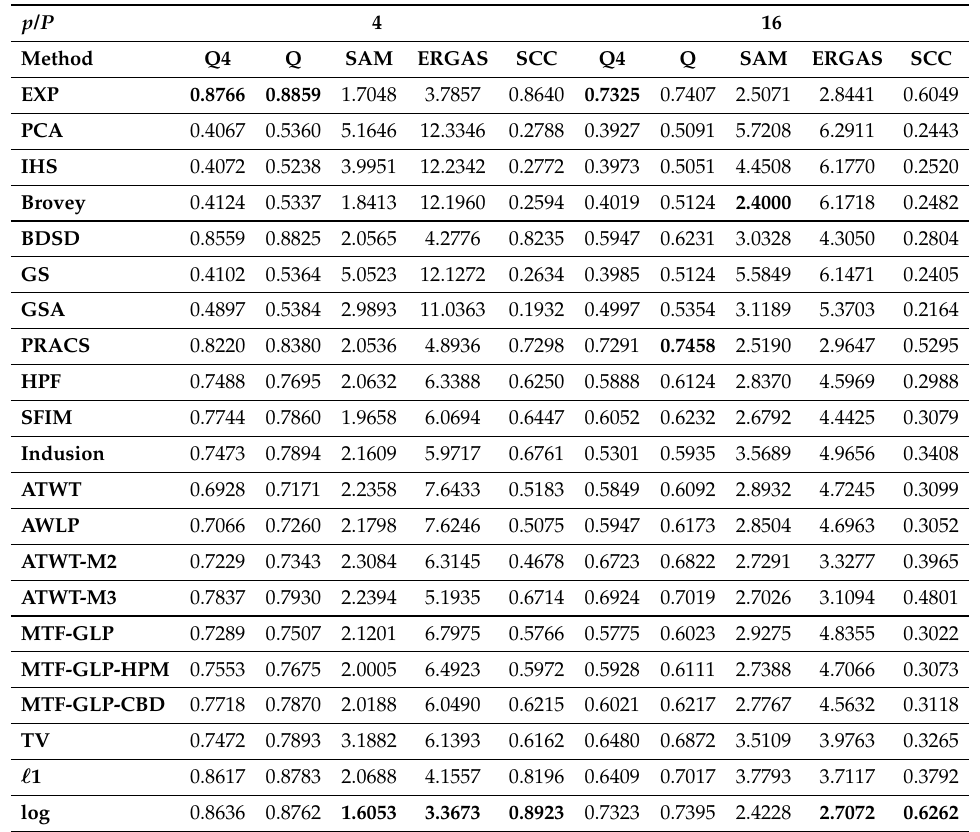
Table 9. Quantitative results using Wald’s protocol on the SPOT-5 Roma image. Bold values indicate the best